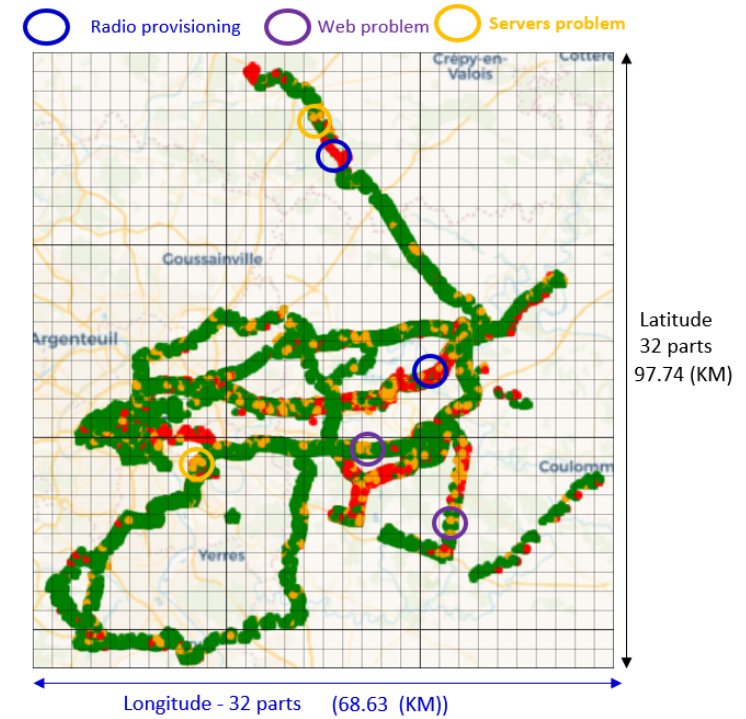
Figure 8. Geographical-based analysis results using 1024 small zones (32 × 32).